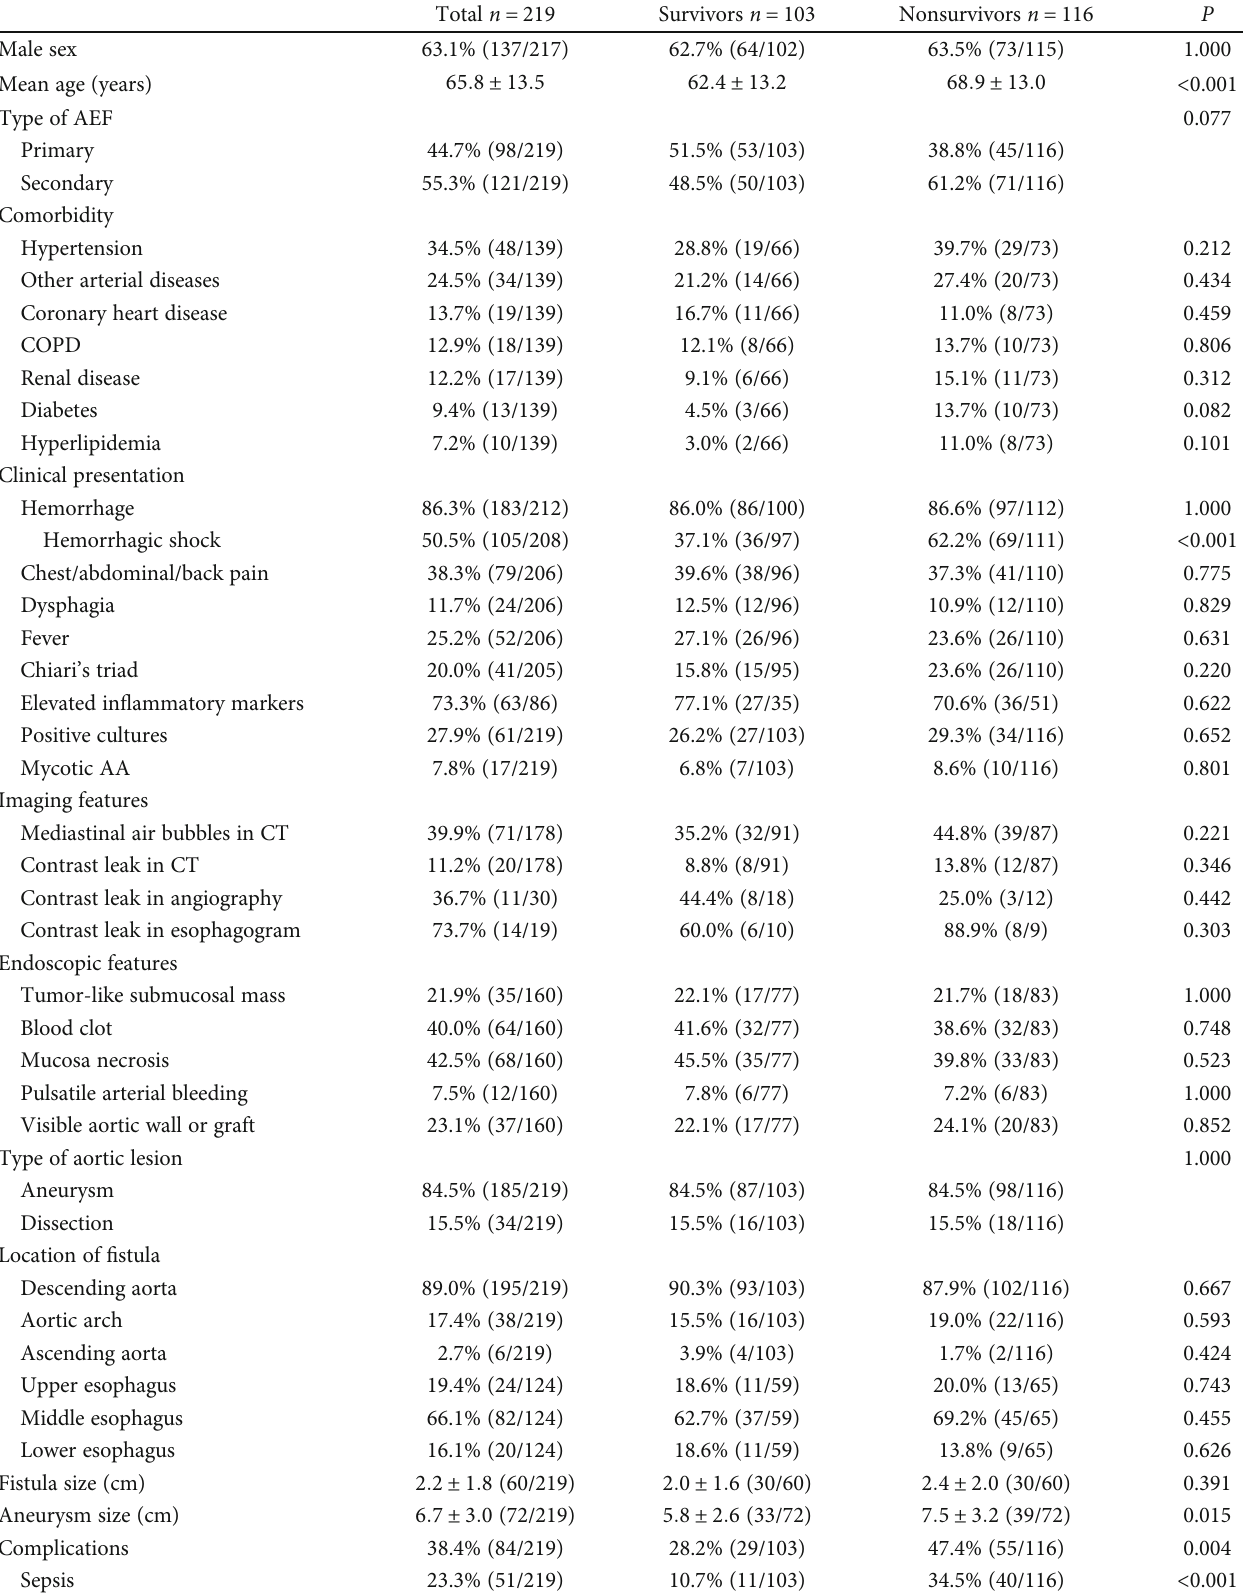
Table 1: Demographic, clinical, radiographic, and endoscopic fi ndings of patients with